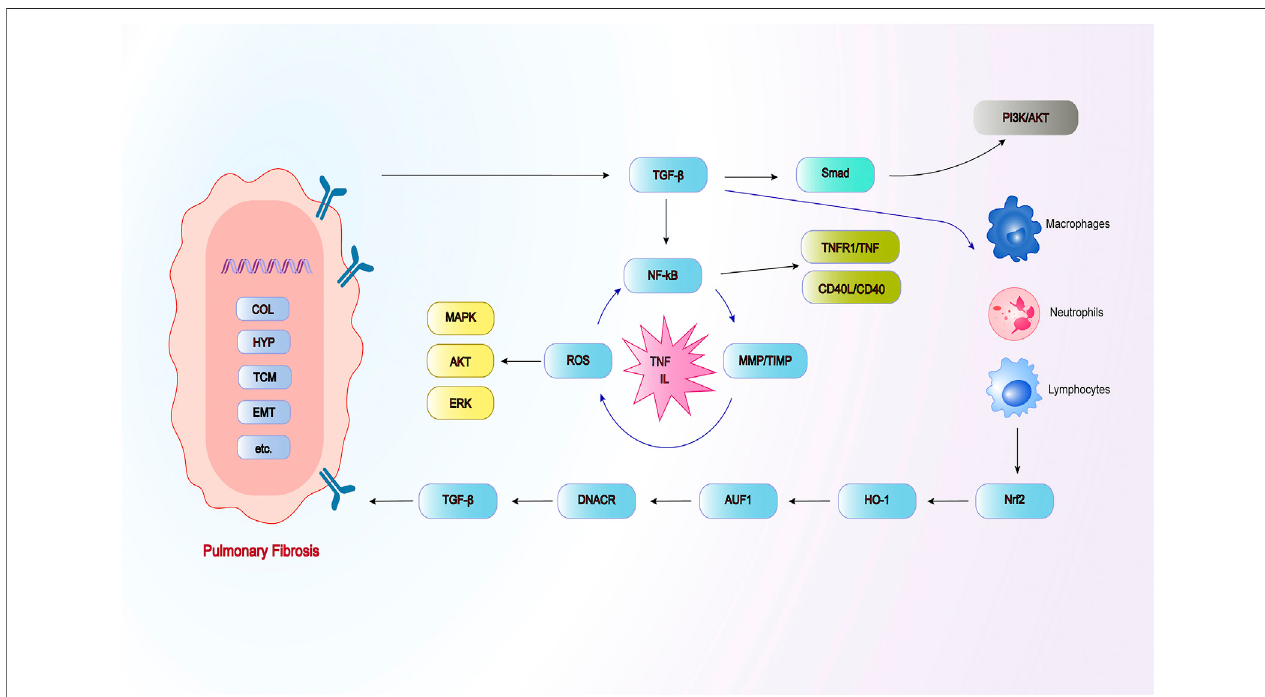
FIGURE 2 | The occurrence and development of PF can be related to these